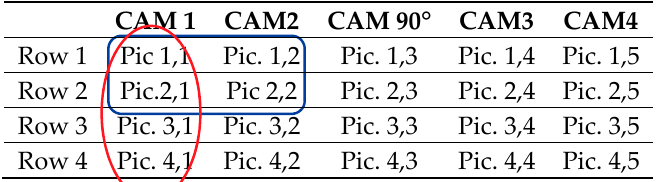
Table 1. Identification of stereo pairs by positional matrix. The ovals mark the overlapping pairs in their respective direction.